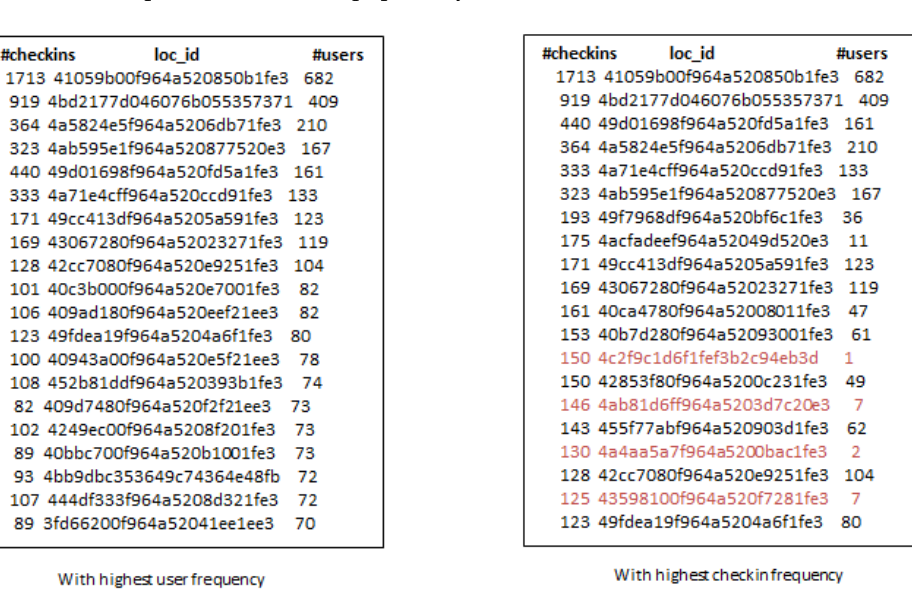
Figure 1. Top-20 locations across San Francisco from Gwalla